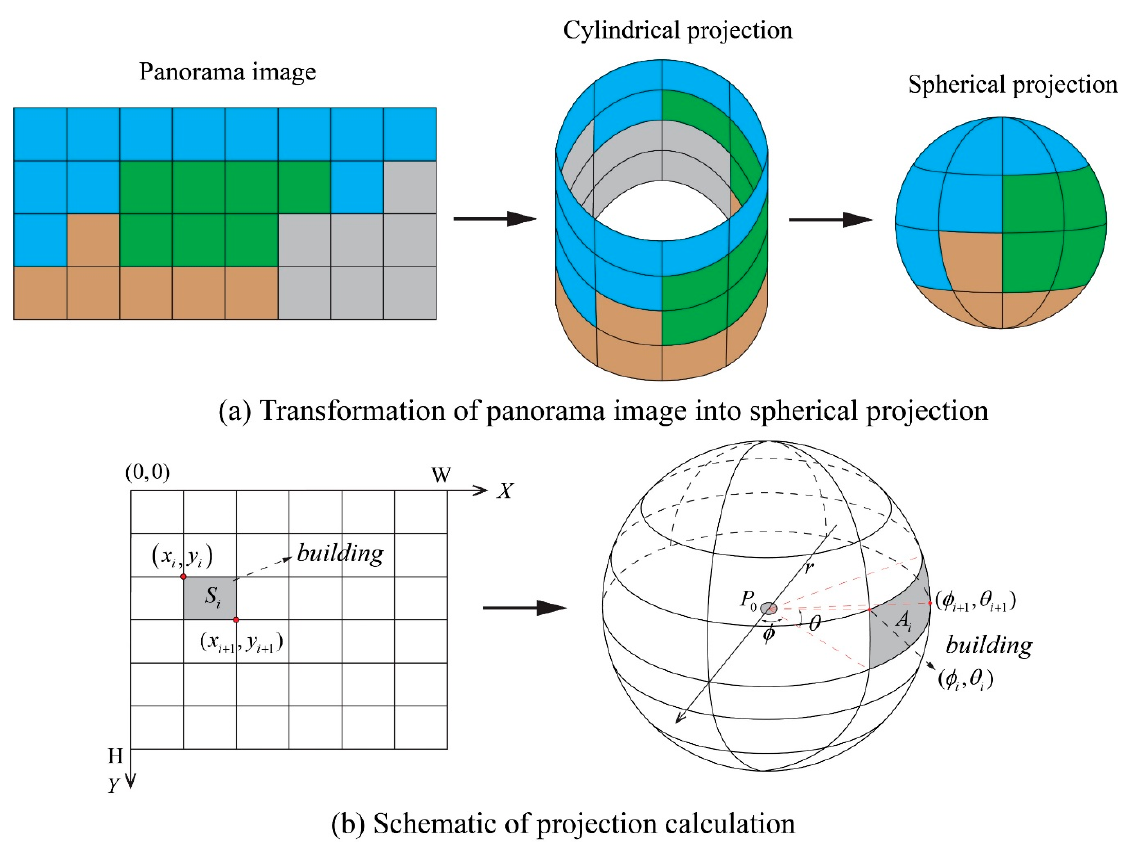
Figure 6. The geometrical transform of equidistant cylindrical projections. ( a ) An illustration of the transformation of a panorama image into a spherical projection, ( b ) schematic of the transformation from an equidistant cylindrical projection to an equidistant azimuthal projection.